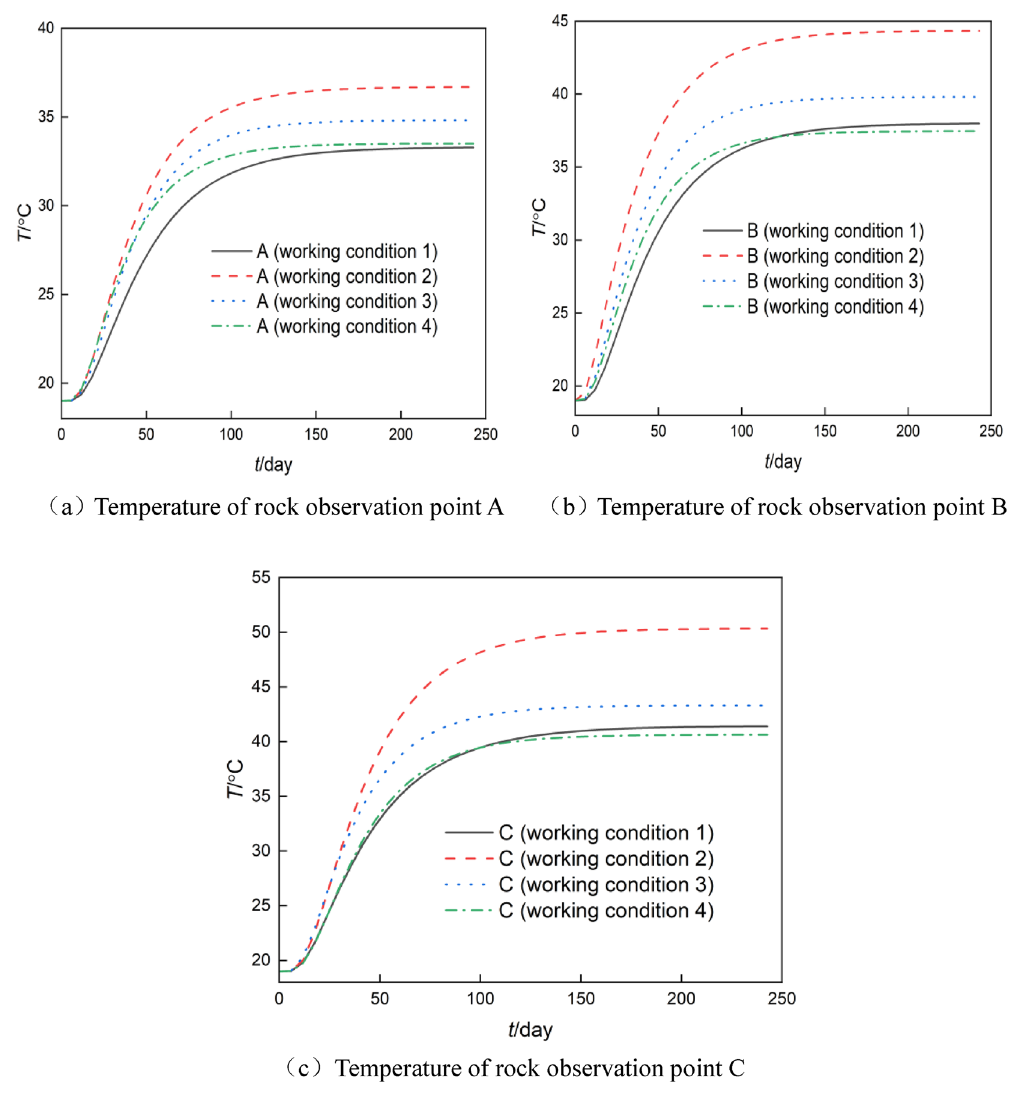
Figure 5. Temperature–time curve of rock observation points A, B, and C.